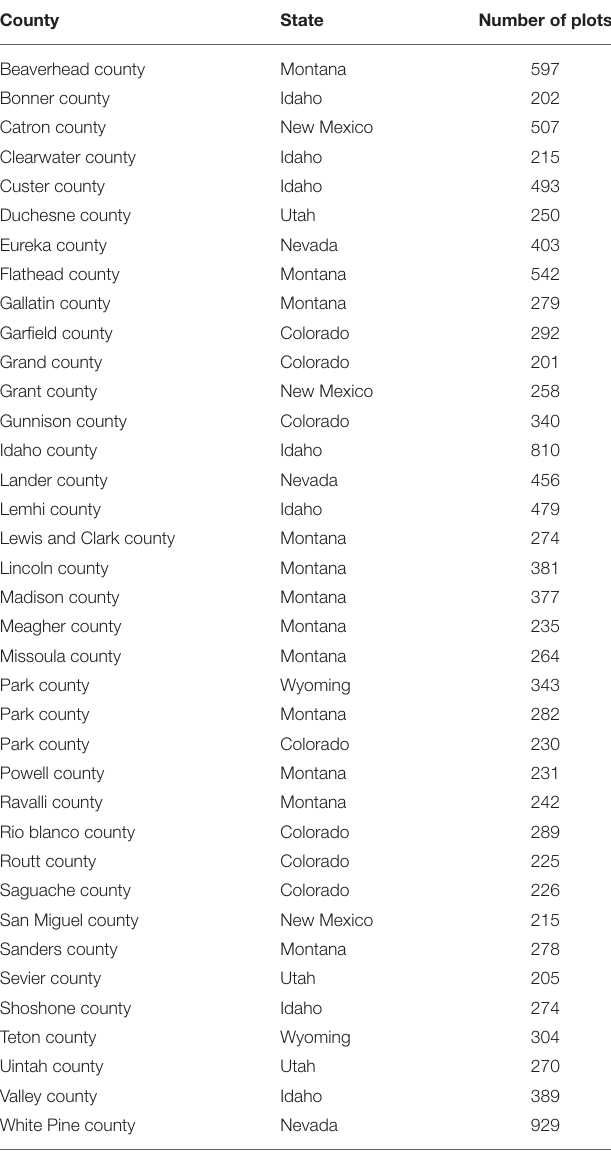
TABLE 1 | Table of the counties included as domains in the